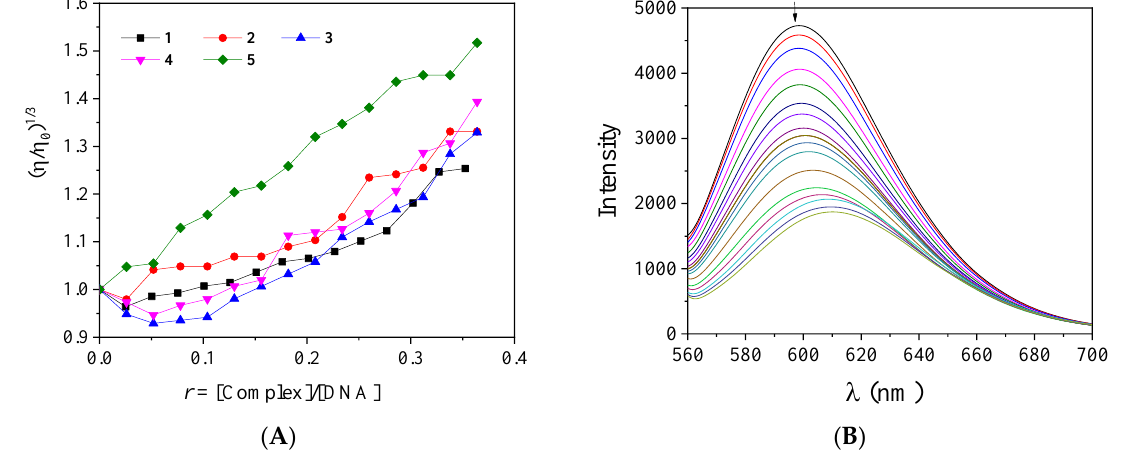
Figure 4. ( A ) Relative viscosity (η/η 0 ) 1/3 of CT DNA (0.1 mM) in buffer solution (150 mM NaCl and 15 mM trisodium citrate at pH 7.0) in the presence of complexes 1 – 5 , at increasing amounts ( r = [compound]/[DNA] = 0 – 0.36). ( B ) Fluorescence emission spectra (λ excitation = 540 nm) for EB-DNA adduct ([EB] = 20 μM, [DNA] = 26 μM) in buffer solution (150 mM NaCl and 15 mM trisodium citrate at pH = 7.0) in the absence and in the presence of increasing amounts of complex 2 (up to r = 0.35). The arrow shows the changes of intensity upon increasing amounts of 2 .